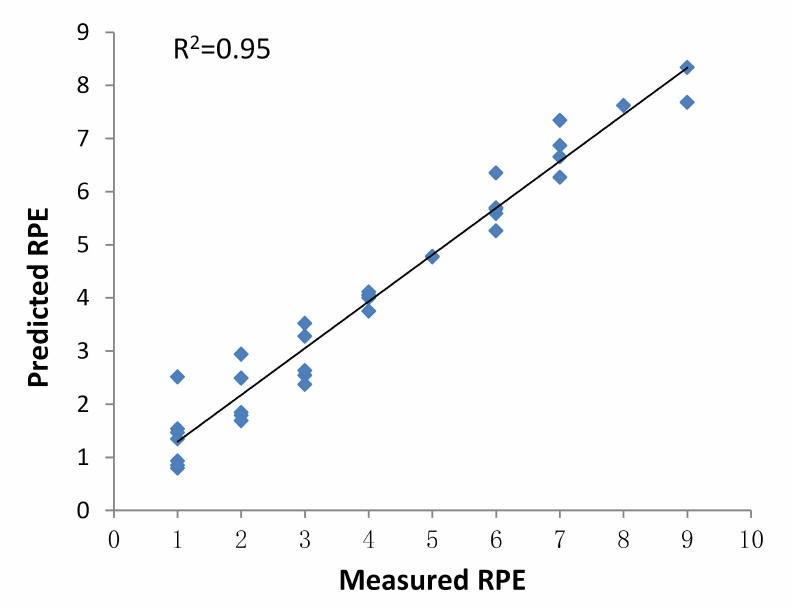
Figure 4. The scatter plot of measured RPE values and predicted RPE values on the test